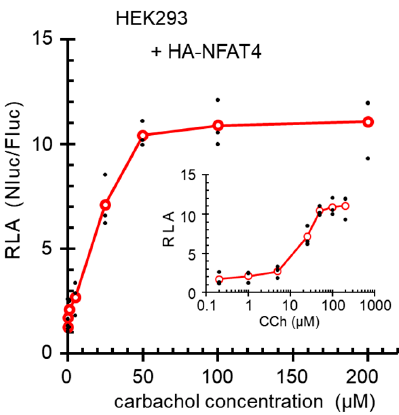
Figure 9. Dose-dependency of the carbachol-stimulated reporter gene activities. HEK293 cells seeded in 24-well plates were co-transfected with pCMV-3 × HA-A/NFAT4 (1 ng), pGL4.53[ luc2/ PGK] (20 ng), and pNL3.2[ NlucP /9 × IL8 NFAT-RE/minP] (50 ng). One day after transfection, cells were unstimulated or stimulated with different concentrations of CCh (0.2–200 µ M) for 6 h. Small dots and unfilled circles represent individual and averaged RLA values obtained from triplicate assays, respectively. A graph in semi-logarithmic scale of CCh concentrations is presented in inset.